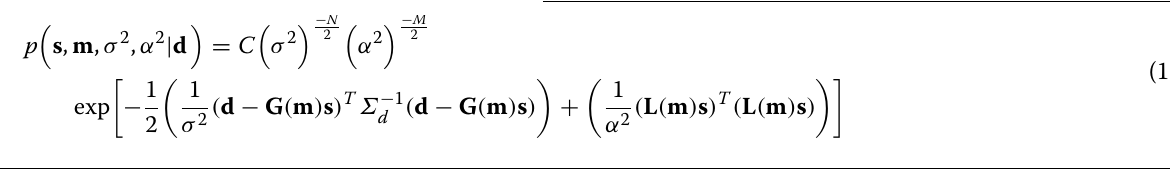
horizontal location of the fault top side, we did not need two parameters because moving the fault parallel to the fault strike would lead to practically an identical result if the fault is set long enough. Therefore, we only intro- duced the location of the mid-point of the fault top side along the northing axis as the location parameter. We fixed the location of the mid-point of the fault top side along the easting axis after preliminary inversions. The linear parameters were the amount of slip on the 280 tri- angular fault elements and the displacement offsets for each InSAR data set. The offsets were required because the InSAR data were not referenced to any point.